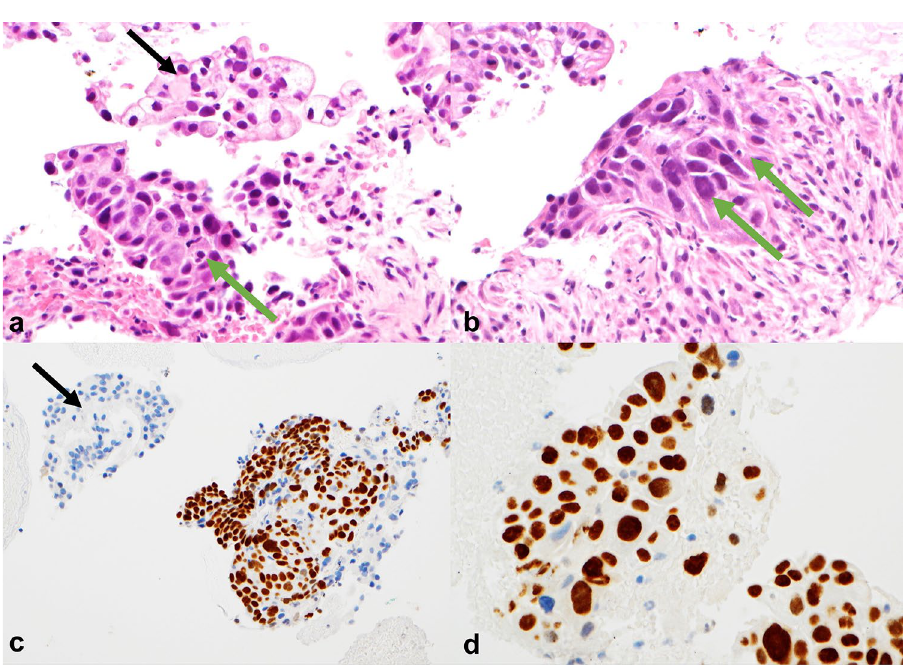
Figure 1. EUS FNB sample morphology (haematoxylin and eosin) and immunohistochemical p40 expression: ( a ) and ( b ) PDAC with intercellular bridges, elongated cells, sharply defined cell borders, dense cytoplasm and angular nuclei with homogenous chromatin (green arrows). Conventional atypical glandular epithelium (black arrows). ( c ) and ( d ) p40 nuclear